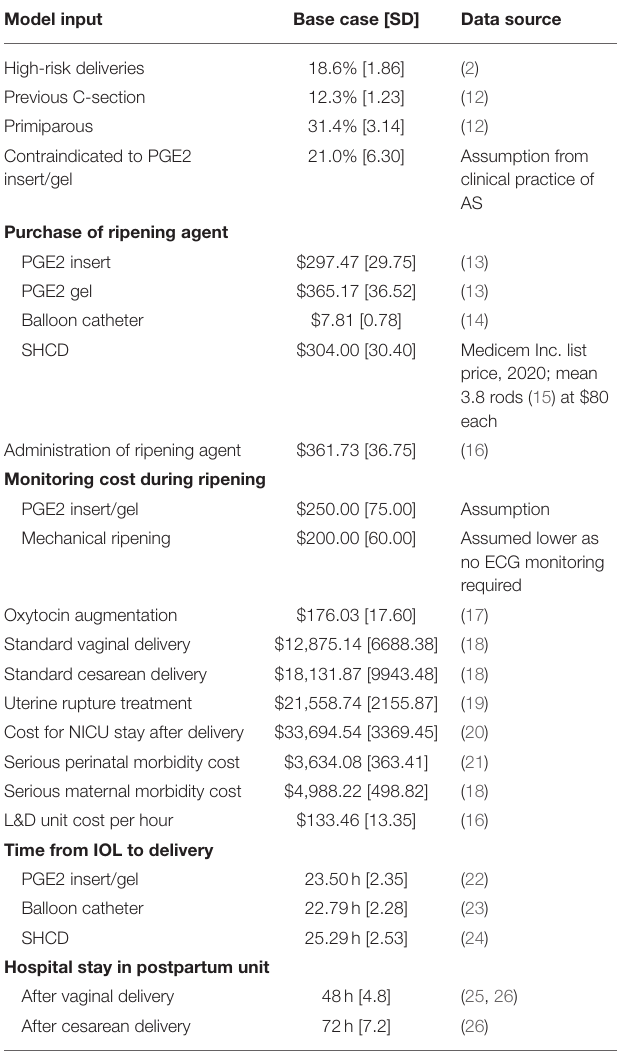
TABLE 1 | Model inputs for patient characteristics, costs, and hospital